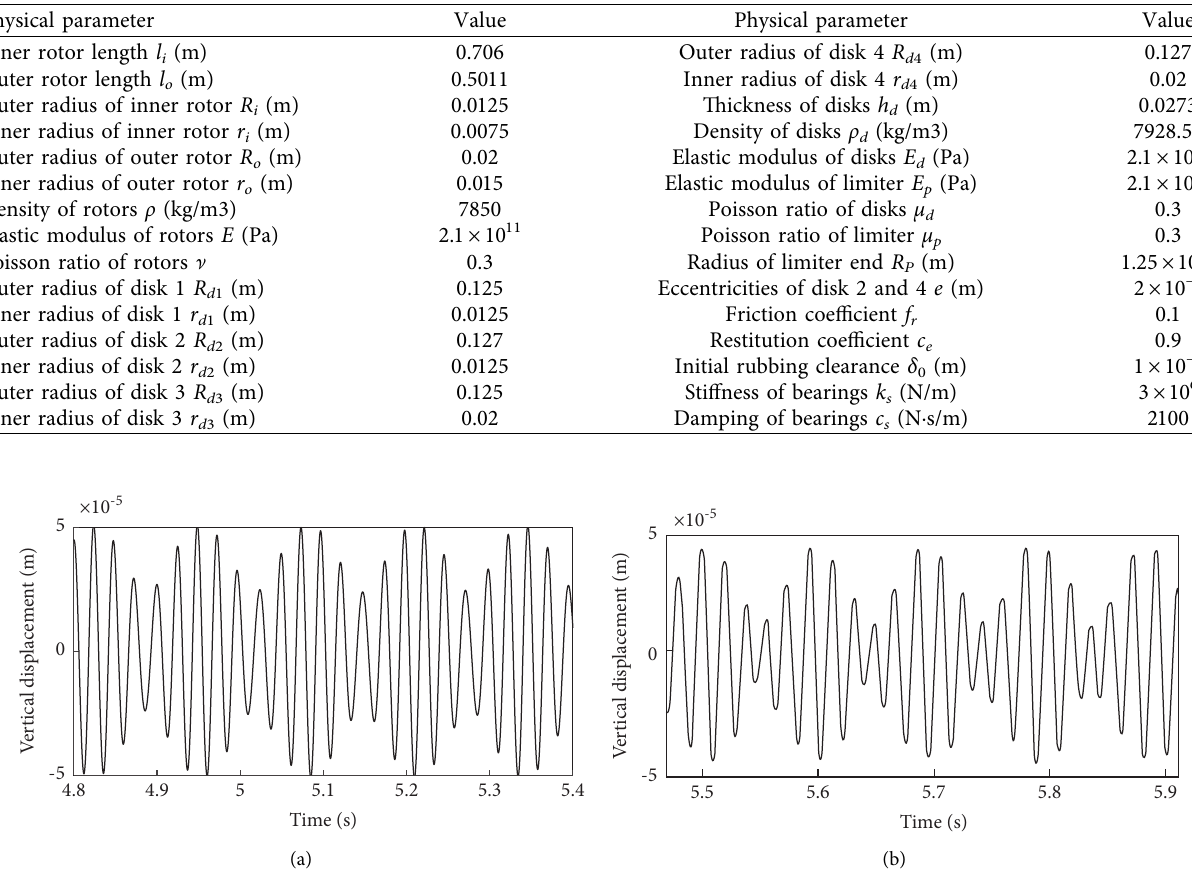
Figure 8: Dynamic responses of dual-rotor system without rubbing. (a) Simulation result. (b) Experimental result